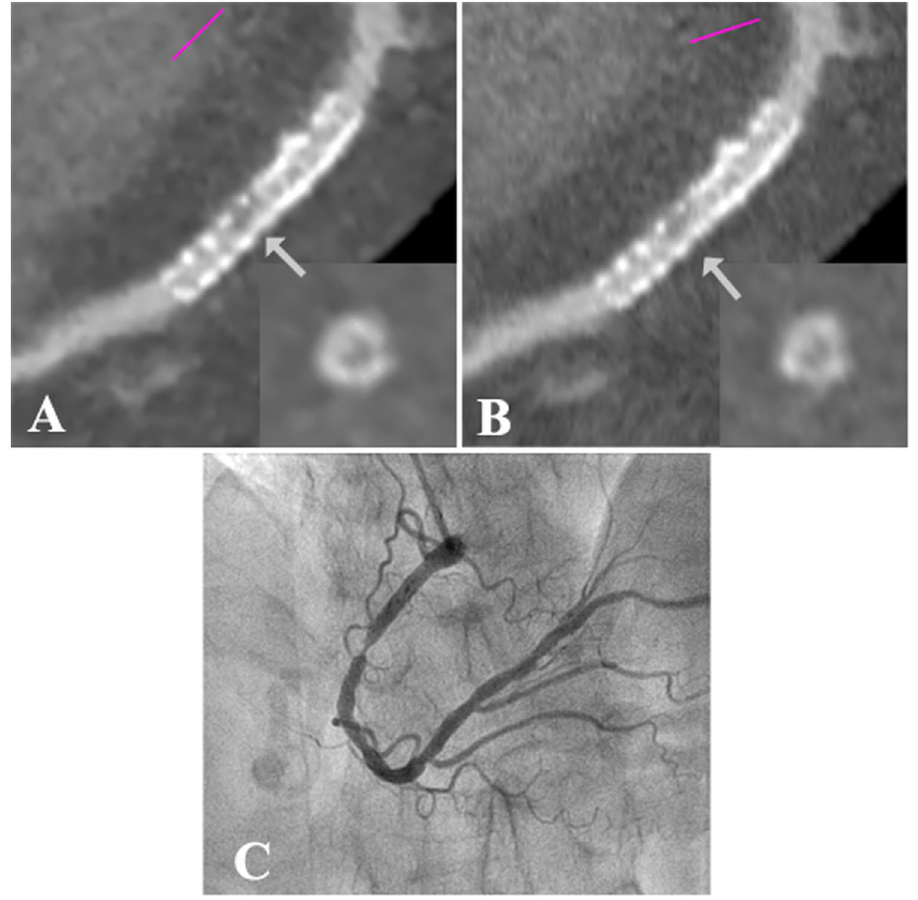
Figure 1. Example of the presence of in-stent restenosis(3.0 mm Diameter Drug-Eluting Stent). ( A ) Sinogram affirmed iterative reconstruction dataset with curved multi-planar reconstruction of the right coronary artery (RCA). Arrow indicates the presence of significant in-stent restenosis. Boxed area clarifies the cross-section view. ( B ) Filtered back projection dataset with curved multi-planar reconstruction of RCA. Arrow indicates the presence of significant in-stent restenosis. Boxed area clarifies the cross-section view. ( C ) Corresponding conventional coronary angiogram showed significant luminal narrowing (plus 50%) of in-stent patency in the mid part of